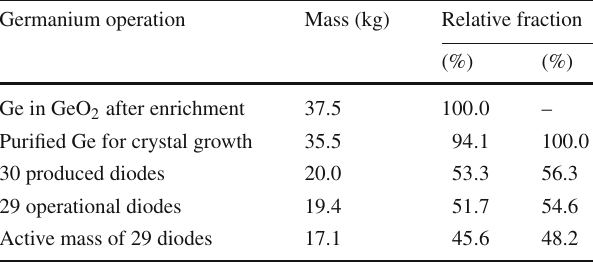
Table 1 Crystal and active mass yield in % from enriched germanium to the final 30 BEGe detectors for Gerda Phase II. The mass transfer fractions are given relative to the original enriched GeO 2 material (3rd column) and to the purified metallic Ge used for crystal growth